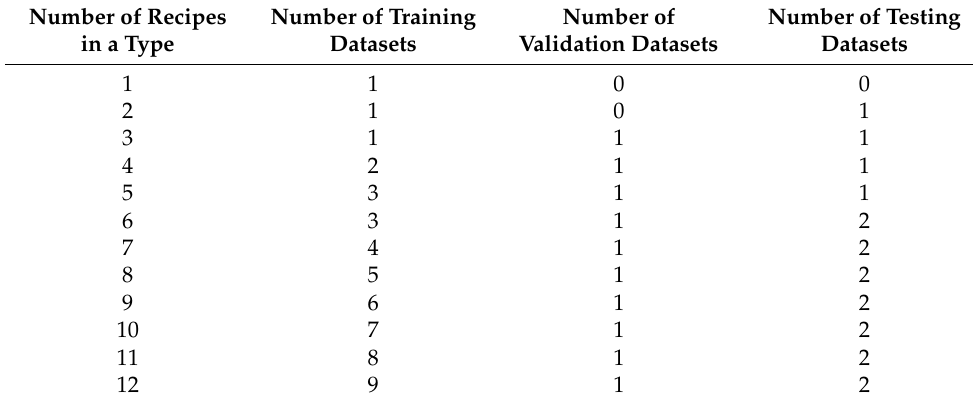
Table 3. Number of datasets after data classification.